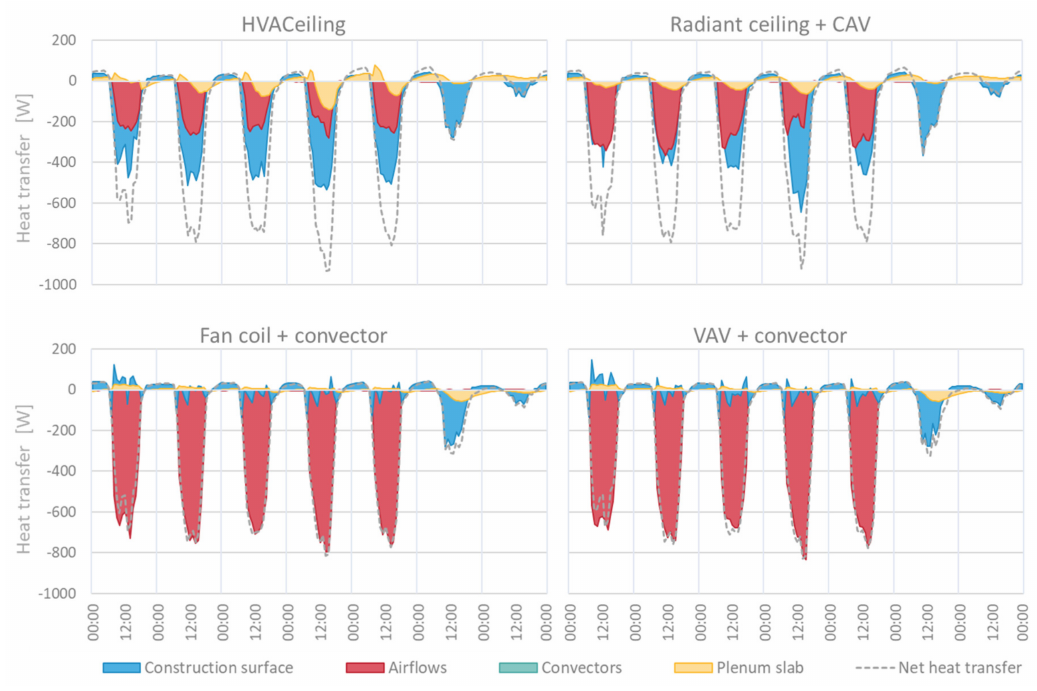
Figure 14. Heating/cooling from constructions, airflows, and heating/cooling units in a warm week in July (12th − 18th) for office S1. Hourly time-series over one week. The sign convention is positive for heat transferred into the room and negative for heat removed from the room.